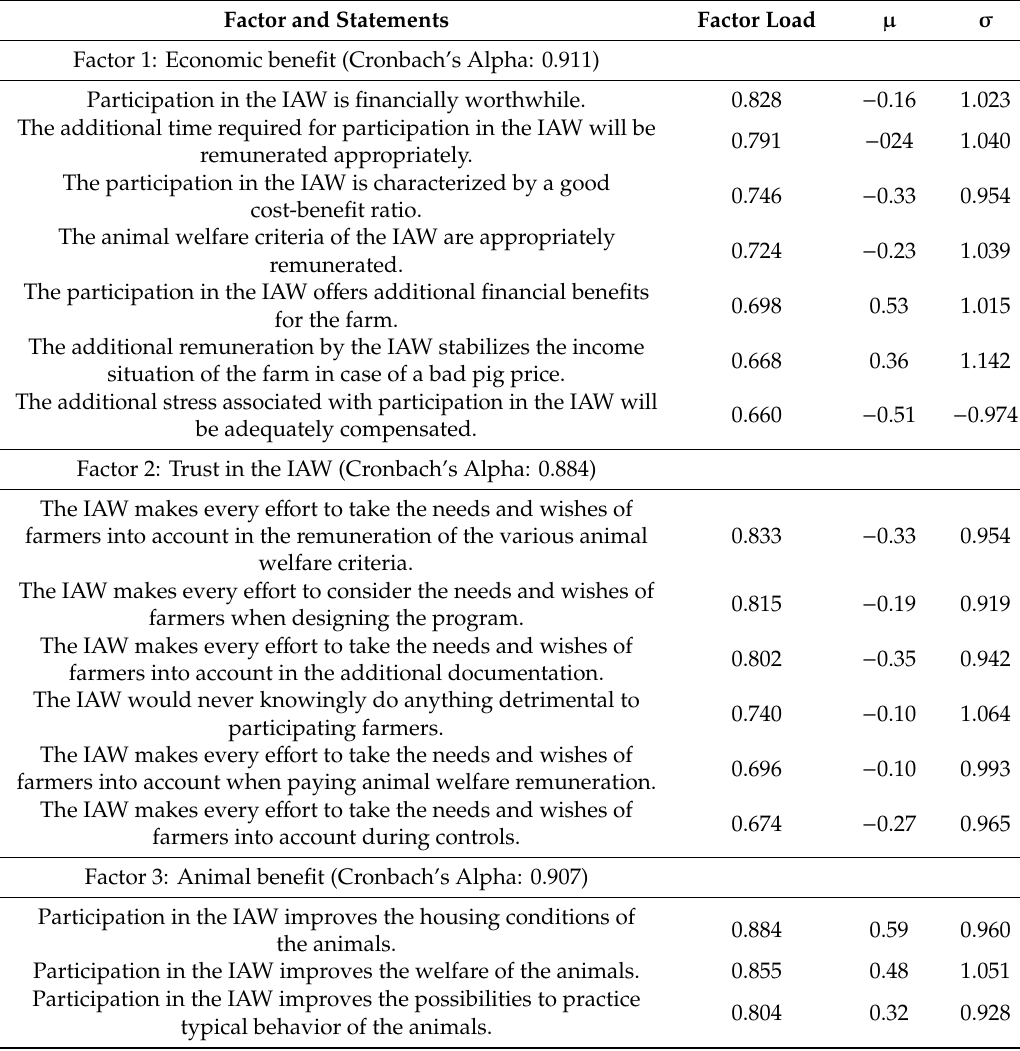
Table 1. Results of the factor